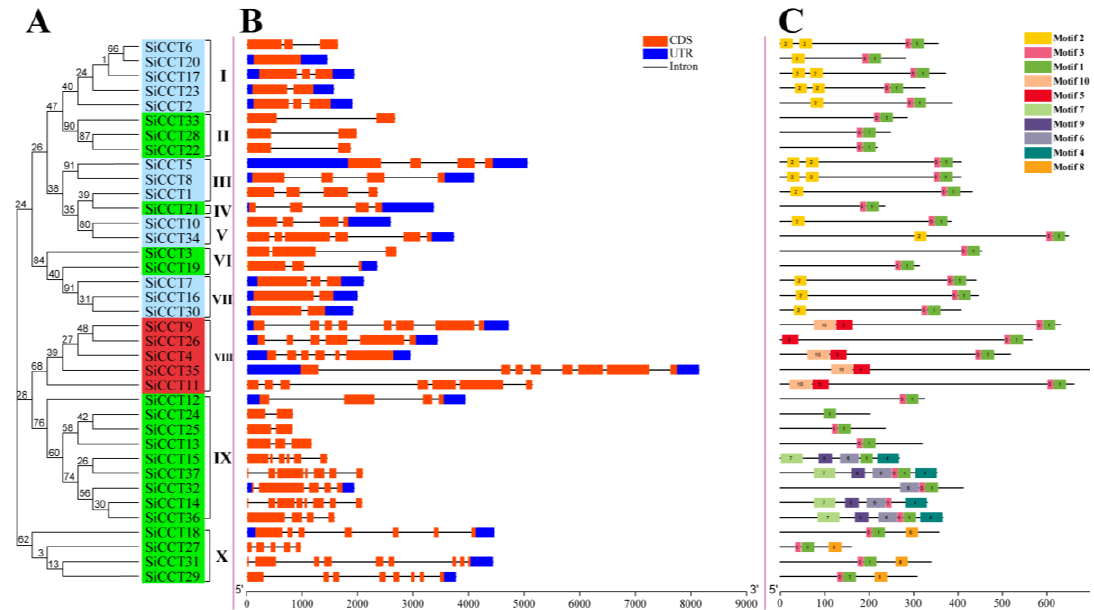
Figure 5. Phylogenetic relationships, gene structure, and conserved motifs of SiCCT proteins. ( A ) Phylogenetic tree constructed based on the domains of the foxtail millet CCT proteins. In the phylogenetic tree, blue areas are members of the COL family, green areas are members of the CMF family, and yellow areas are members of the PRR family. ( B ) Exon–intron structure of foxtail millet CCT genes. Blue boxes indicate the 5 (cid:48) and 3 (cid:48) untranslated regions; a red box represents an exon, and black lines represent introns. ( C ) Motif composition of foxtail millet CCT proteins. The motifs, numbered 1–10, are indicated by different colored